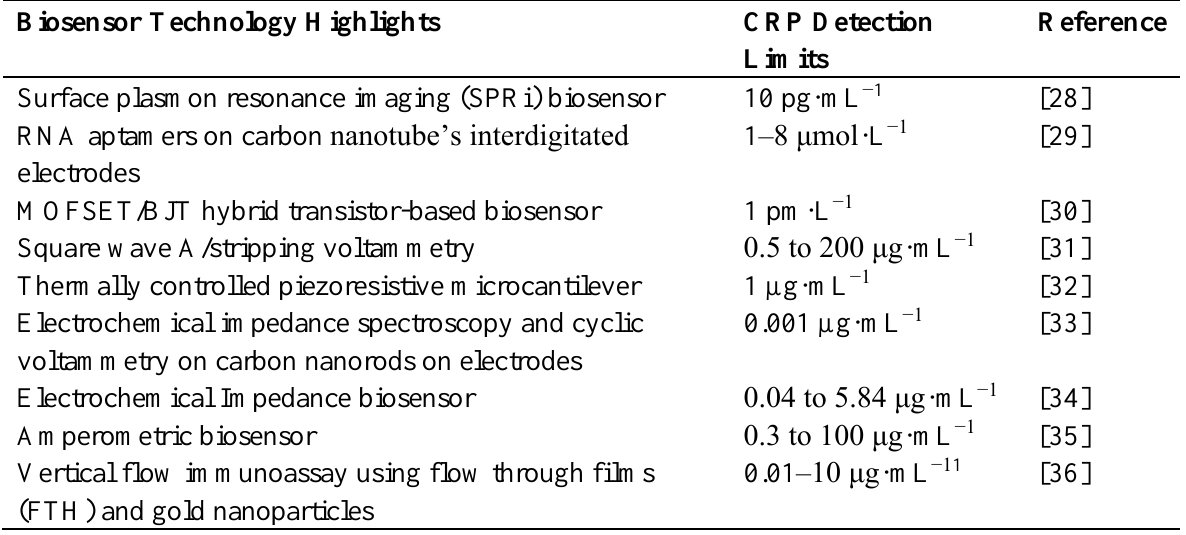
Table 1. Biosensors for C-reactive protein